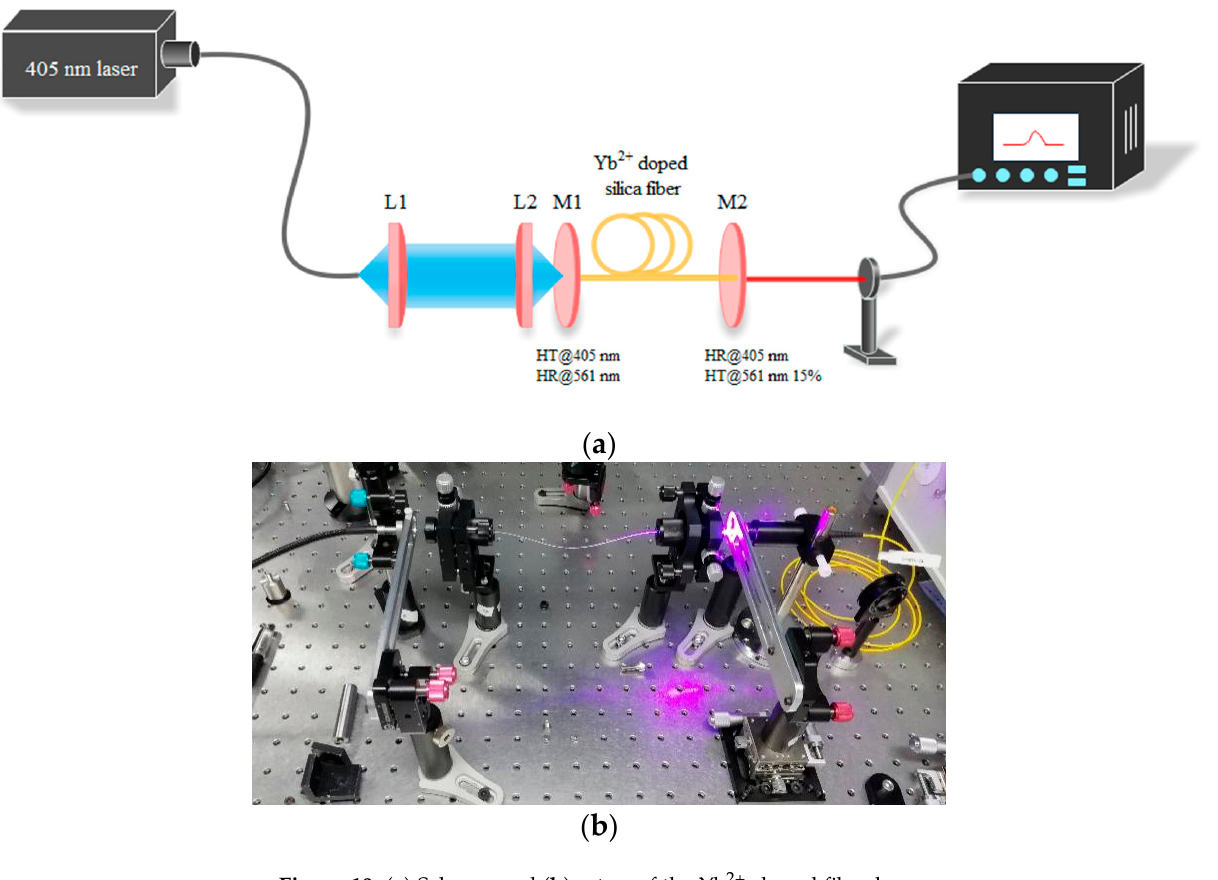
Figure 10. ( a ) Scheme and ( b ) setup of the Yb 2+ -doped fiber laser.